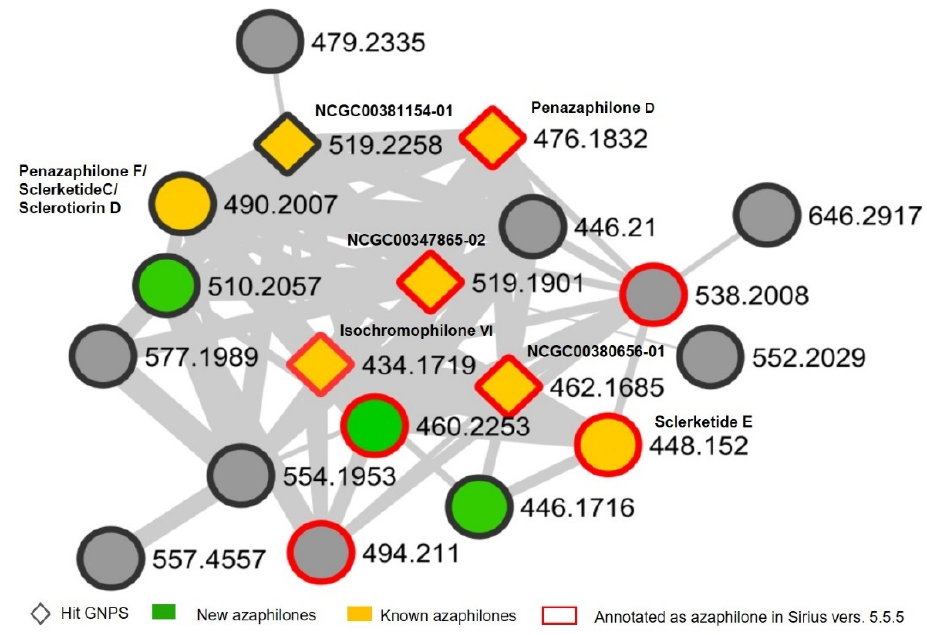
Figure 1. Cluster of azaphilones obtained from the molecular network of P. hirayamae crude extract and annotated by GNPS databases and Sirius vers. 5.5.5.